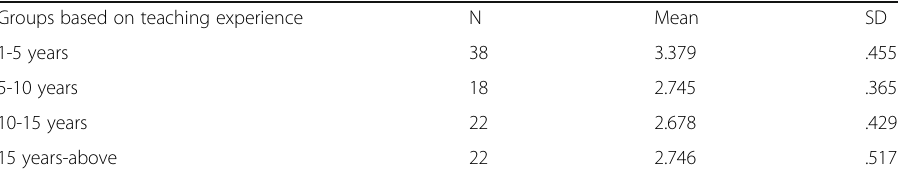
Table 5 Descriptive statistics Groups based on teaching